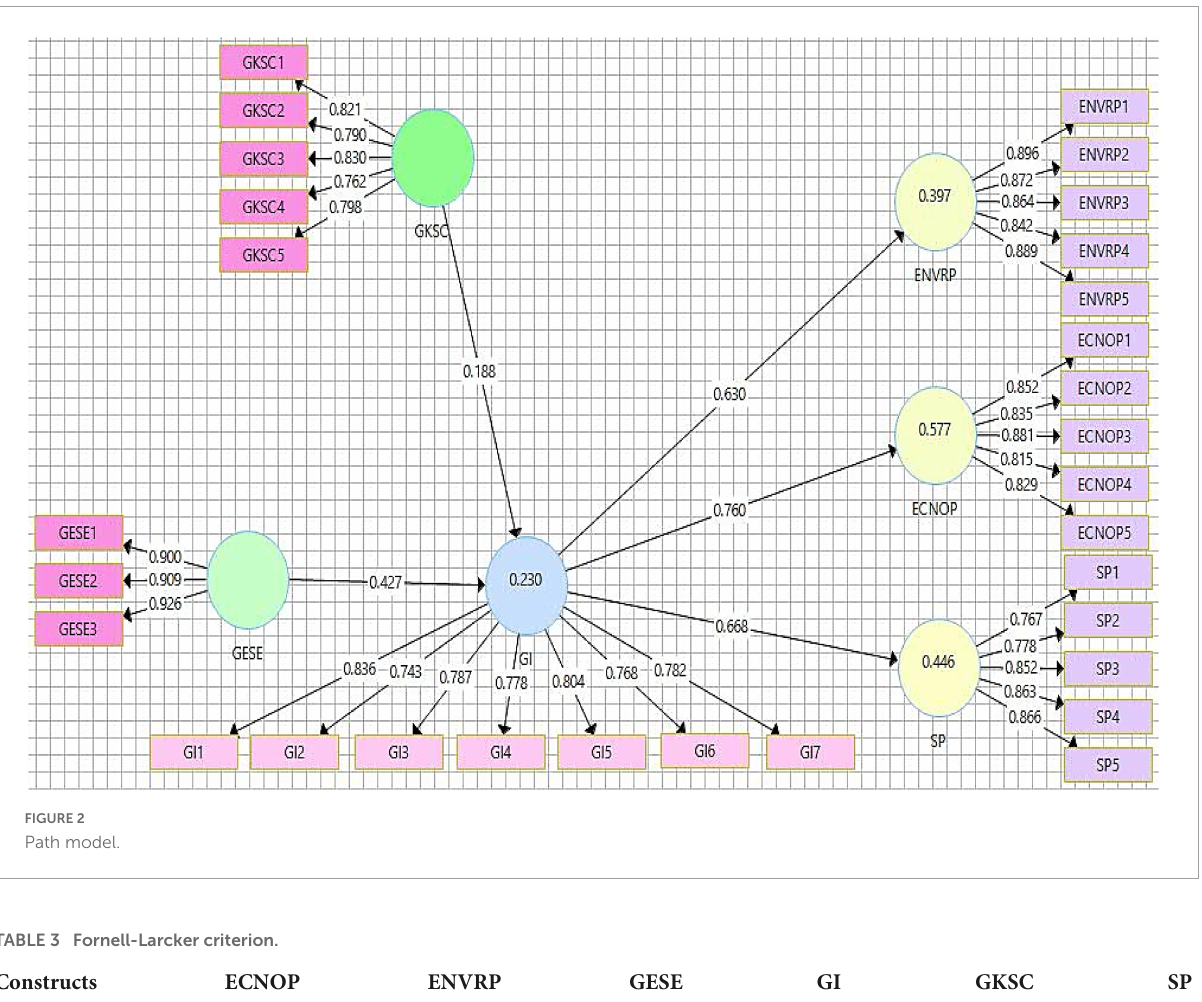
TABLE 3 Fornell-Larcker criterion.